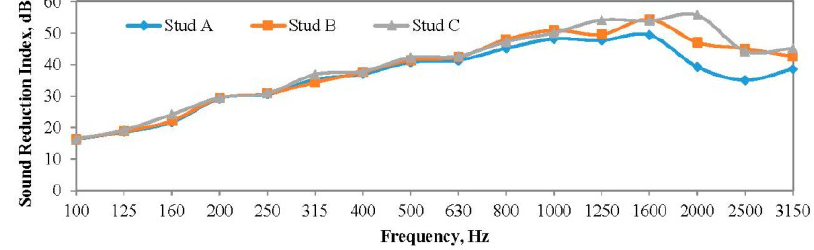
Figure 12. R values using FEA for a metal-framed wall using various stud